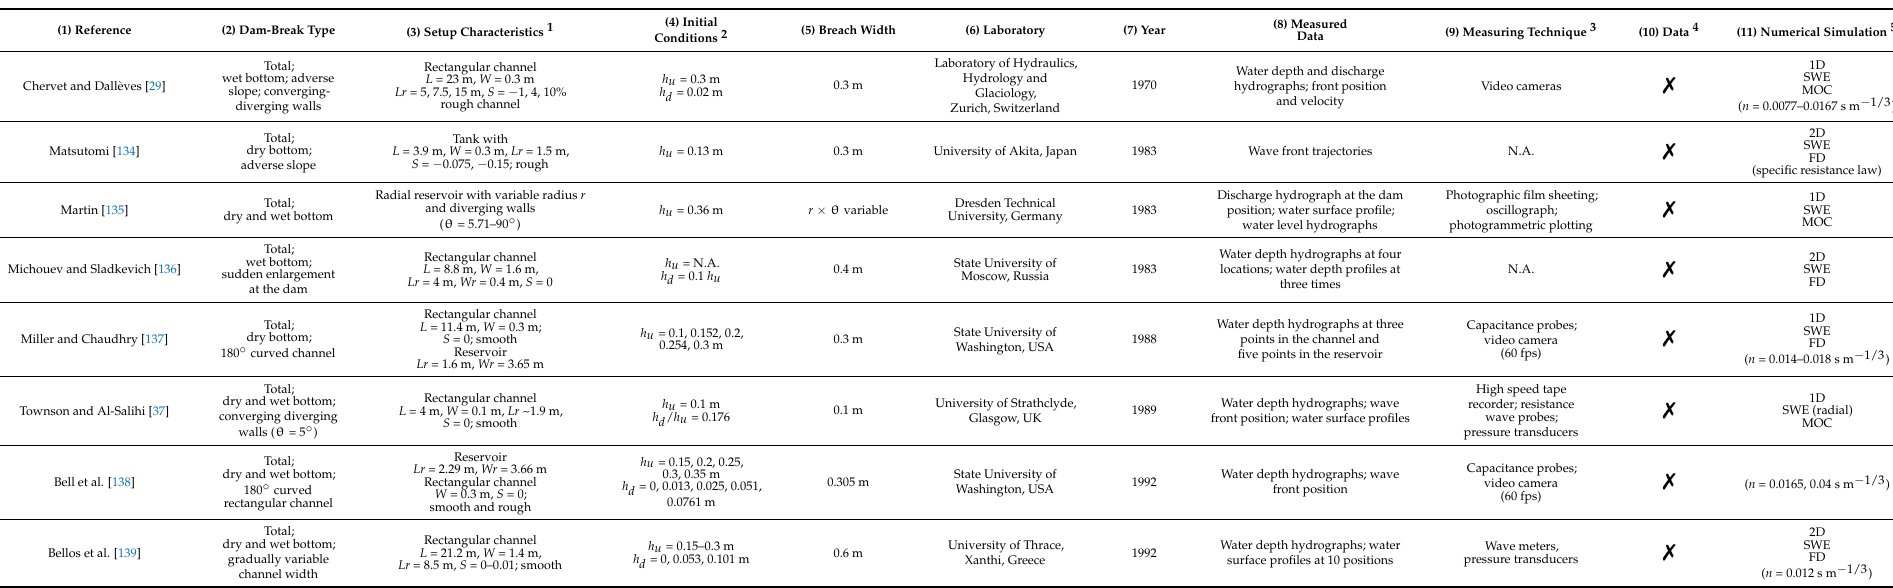
γ = Bazin roughness coefficient; N.A. = not available. Table 2. Experimental investigations of dam-break waves through geometric singularities.